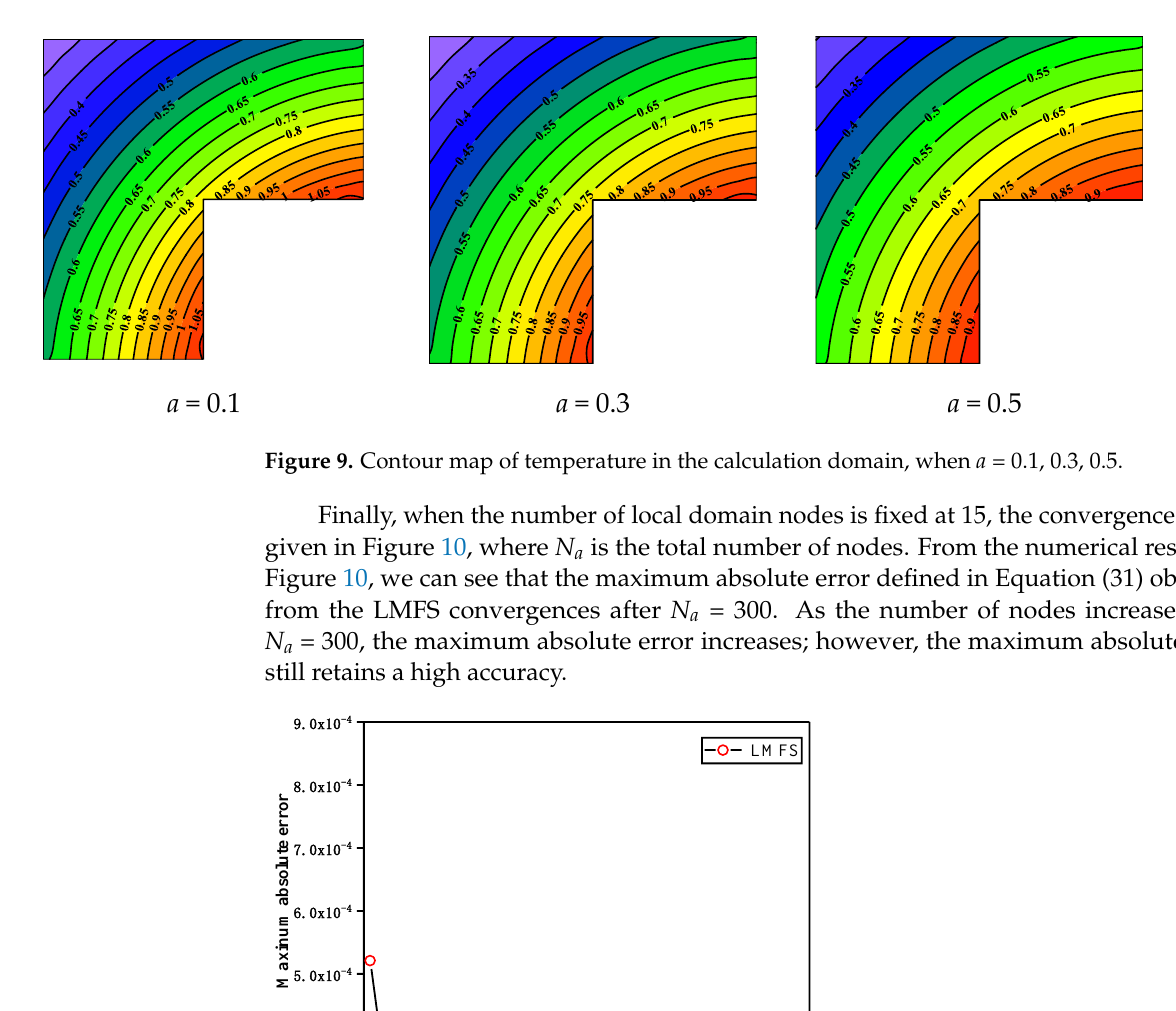
which is consistent with Equation (52).